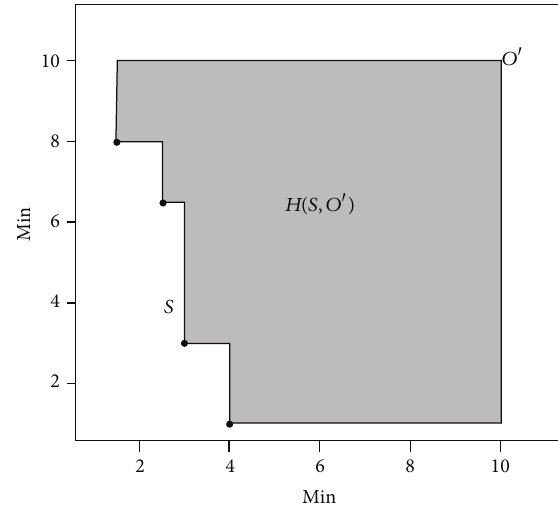
Figure 7: The hypervolume index in the minimization